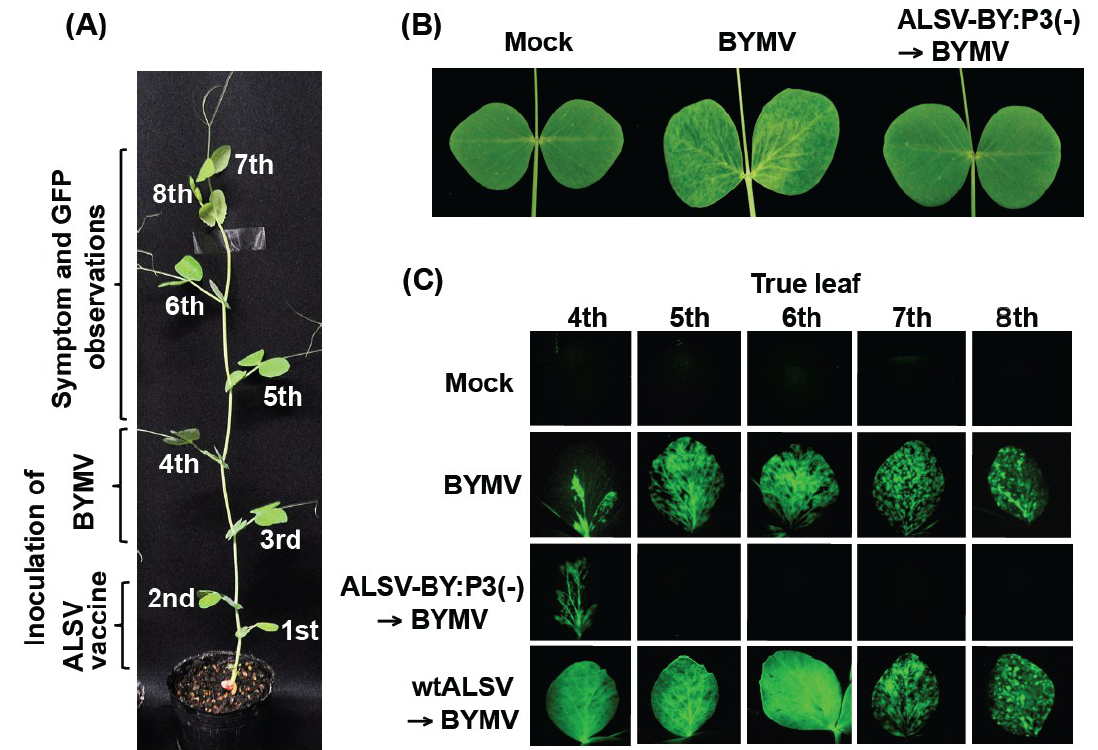
Figure 1. Protective effects of pre-inoculating pea plants with an Apple latent spherical virus (ALSV) vaccine (ALSV-BY:P3(−)) on challenge inoculation with a recombinant Bean yellow mosaic virus (BYMV) expressing green fluorescent protein (GFP). ( A ) Leaf positions on a pea plant for inoculation with ALSV vaccine and BYMV and observation of symptoms and GFP fluorescence. Pea seedlings (three-leaf stage) were pre-inoculated with the vaccine by rub-inoculating a concentrated ALSV preparation (10 µL per leaf) on the first and second leaf and a crude BYMV extract of IbG-GFP-inoculated N. benthamiana was used for challenge inoculations by the carborundum method on the third and fourth leaves of seedlings that had grown to the five-leaf stage; ( B ) Leaf symptoms due to BYMV infection (seventh true leaf)